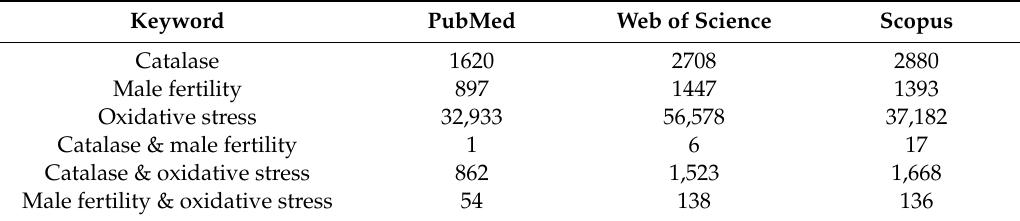
Table 1. Number of publications in each database according to the di ff erent keywords utilised, after applying the inclusion criteria.